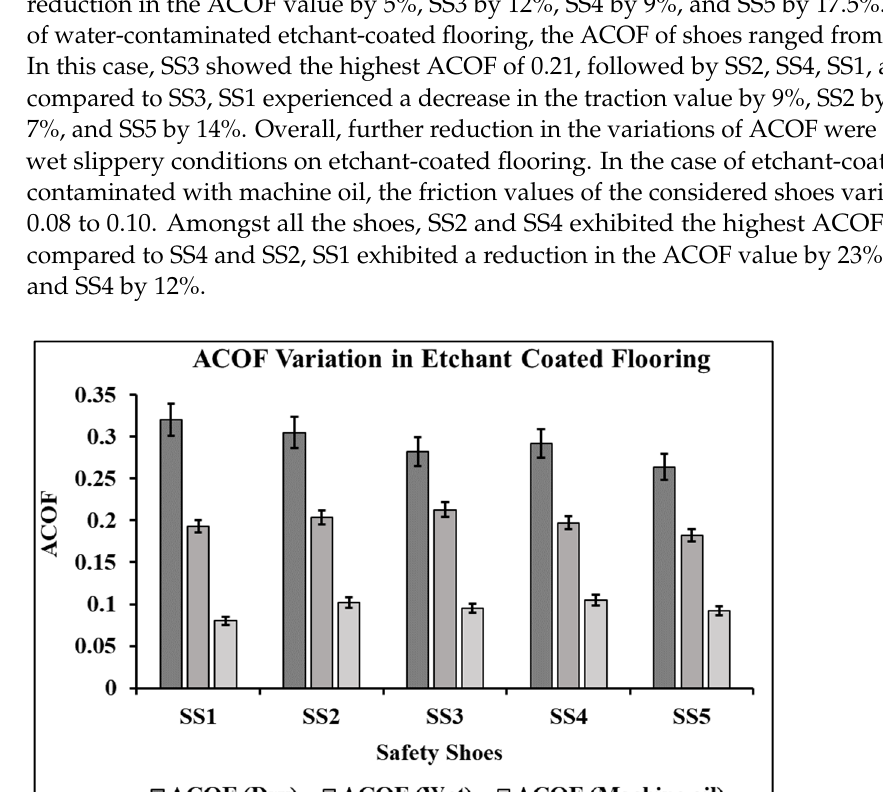
Figure 4. ACOF variation in uncoated laminate flooring across dry, wet, and machine oil slip set- ting.